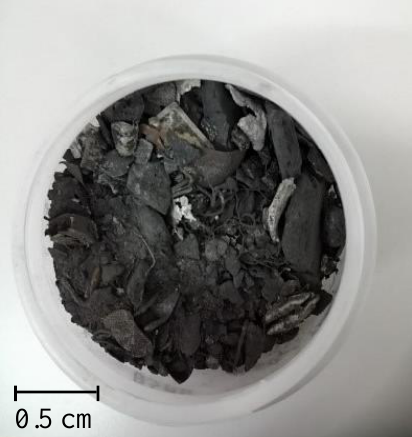
Figure 3. Solid WPCBs material after thermal pre-treatment and the I leaching (4M H 2 SO